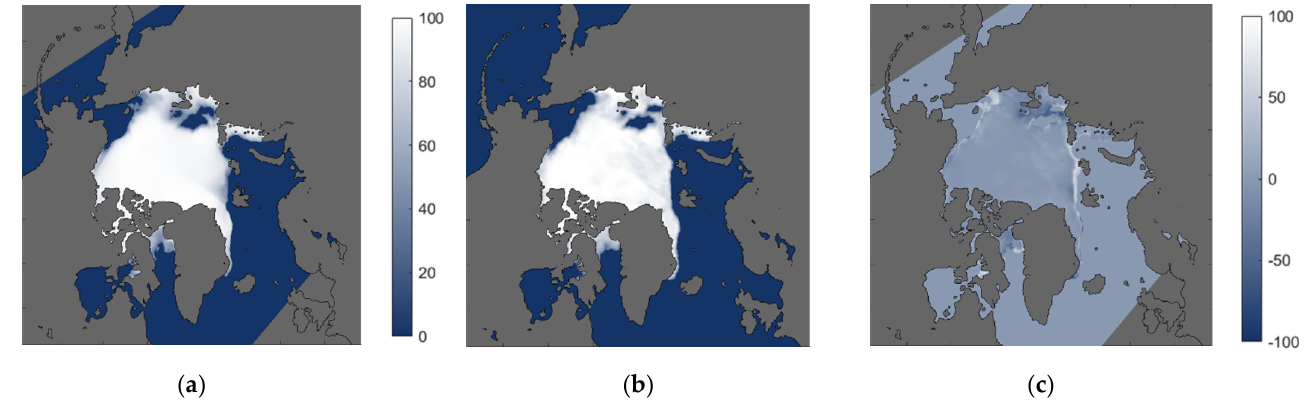
Figure 7. SIC (%) Arctic maps using MWR data from 7 November. ( a ) FMPL-2 MWR map, ( b ) Ground truth map, ( c ) Error map. Although the maps are downscaled to 12.5 km, the results are blurred because of the size of the footprint. Therefore, most of the errors accumulate at the transitions between sea and ice, where the SIC is lower. Figure 8 shows the error histogram for each one of the different SIC areas. The results for the North pole SIC maps present a global MAE of 1.95%.